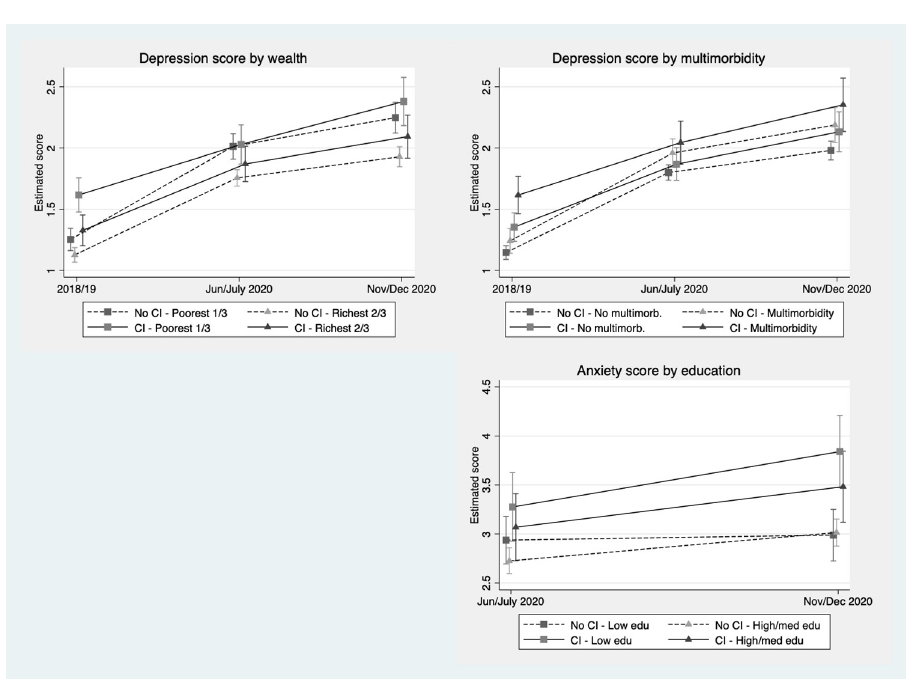
Fig 5. Significant inequalities relating mental health and cognitive function (estimated scores and 95% confidence intervals, adjusted for all available covariates).